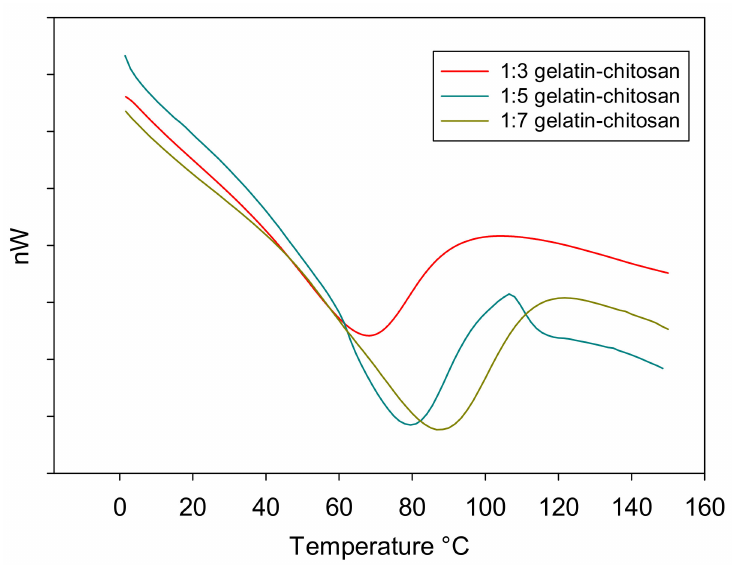
Figure 7. Differential scanning calorimetry (DSC) curve of the modified membrane foam at chi- tosan:gelatin composition ratios of 1:3, 1:5, and